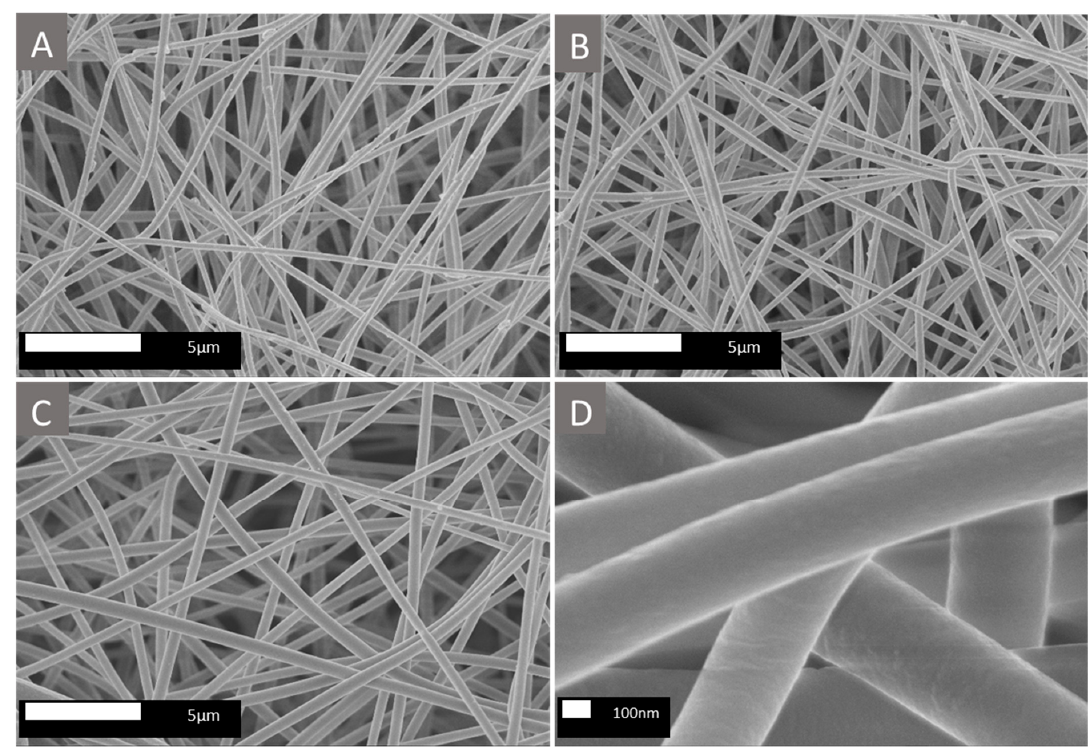
Figure 3. Scanning electron microscopy (SEM) images of pristine PAN nanofibrous membranes of ( A ) Exp. 1, ( B ) Exp. 2, ( C ) Exp. 3, and ( D ) a high-resolution image of Exp. 3.